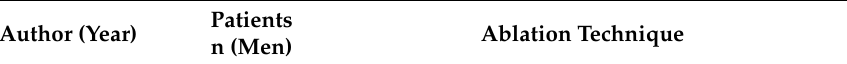
Table 1. Major series of ventricular tachycardia ablation outcomes in arrhythmogenic